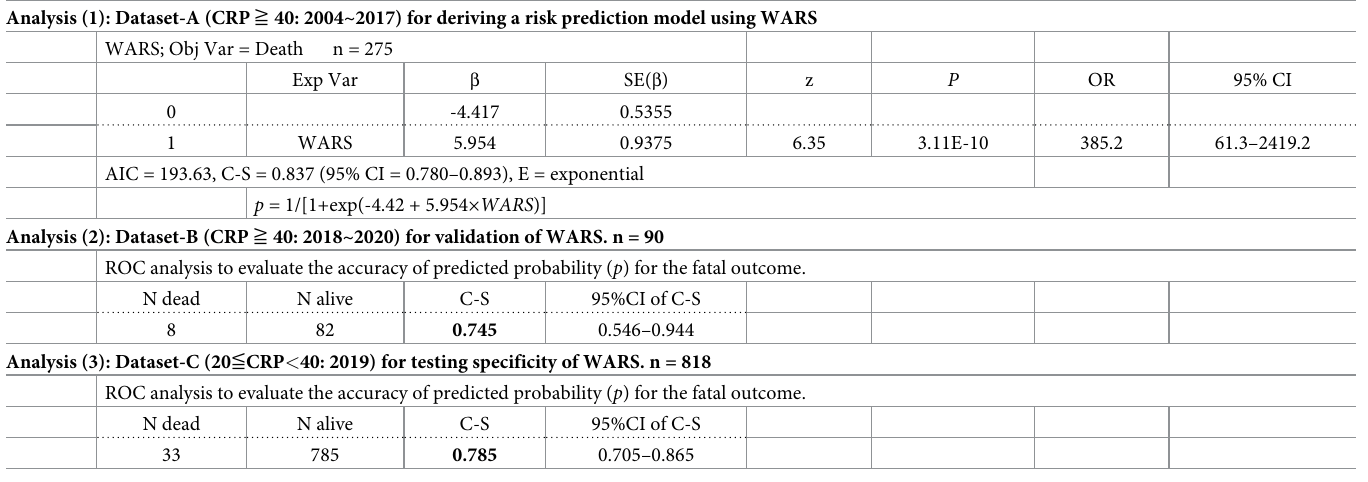
Table 4. Accuracy of WARS computed from 10 risk variables for predicting 72-hour mortality. Analysis (1): Dataset-A (CRP ≧ 40: 2004~2017) for deriving a risk prediction model using WARS WARS; Obj Var = Death